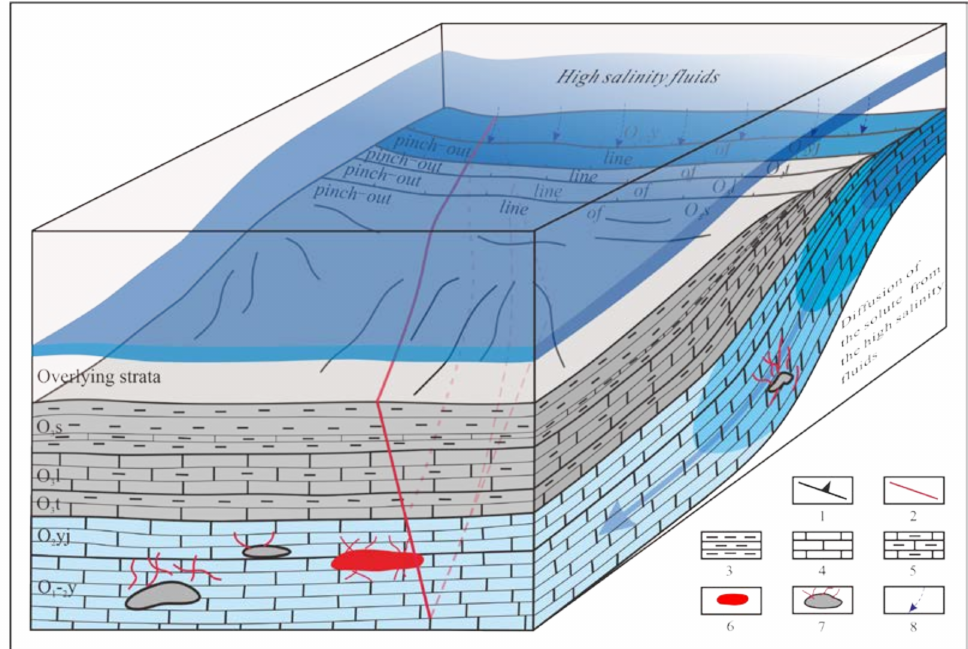
Figure 9. Migration direction pattern of high salinity fluids and hydrocarbon in the Halahatang depression 1: pinch-out line; 2: faults; 3: mudstone; 4: limestone; 5: muddy limestone; 6: hydrocarbon reservoir; 7: karst fracture-cavity; 8: high salinity fluids entered the Ordovician strata. The TDS in the Ordovician is controlled by the caprock and the high salinity fluids from overlying strata and adjacent